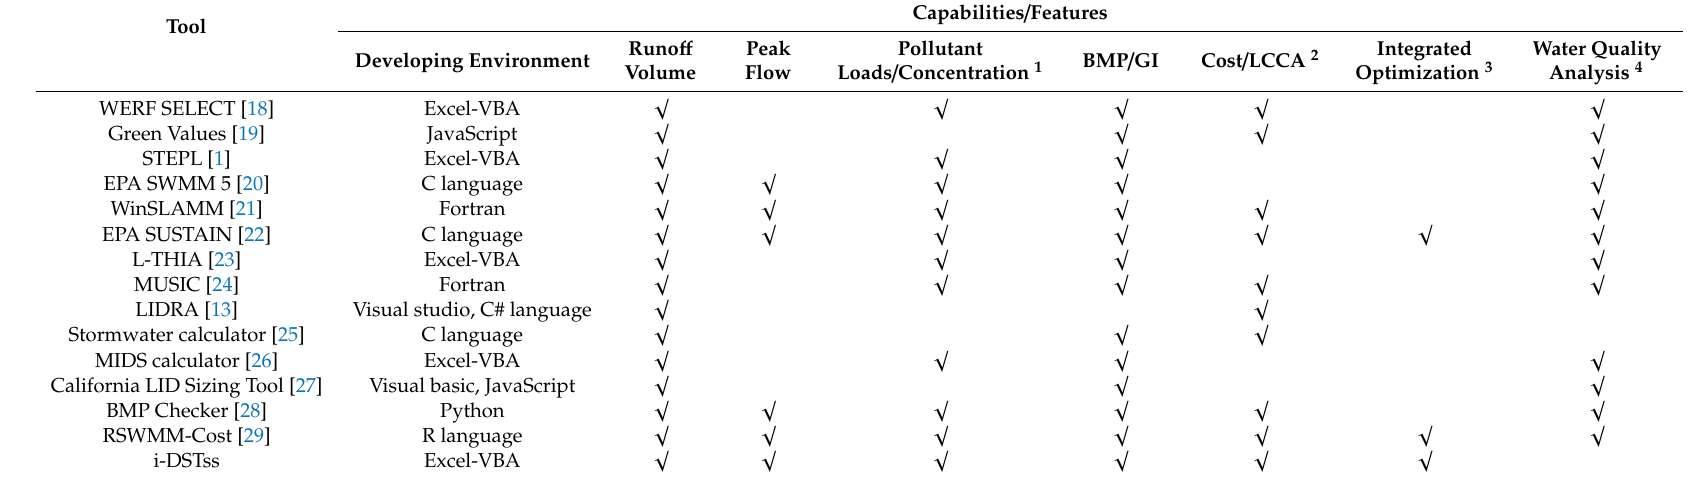
Table 1. Comparison of existing stormwater management